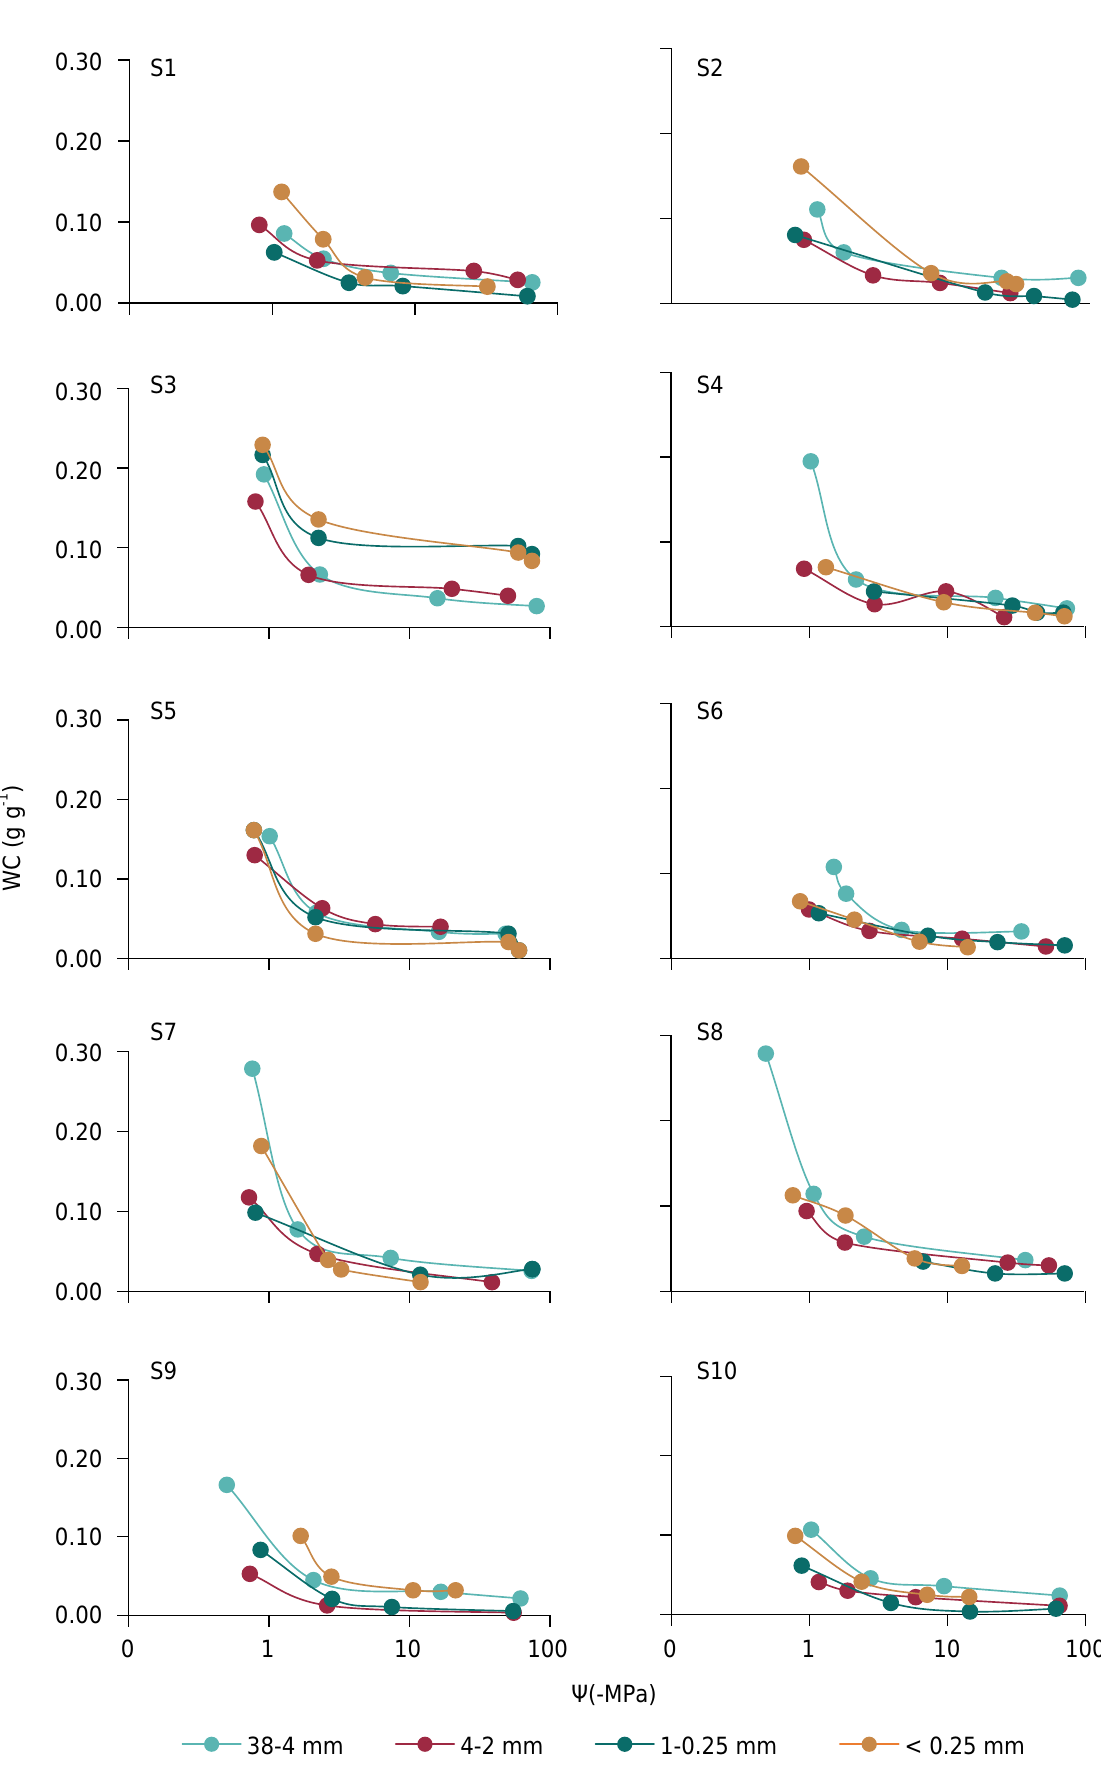
Figure 4. Water content (WC) and potential (Ψ) relationship for ten samples of saprolite (S1 to S10) fractionated into different sizes (legend of the upper left